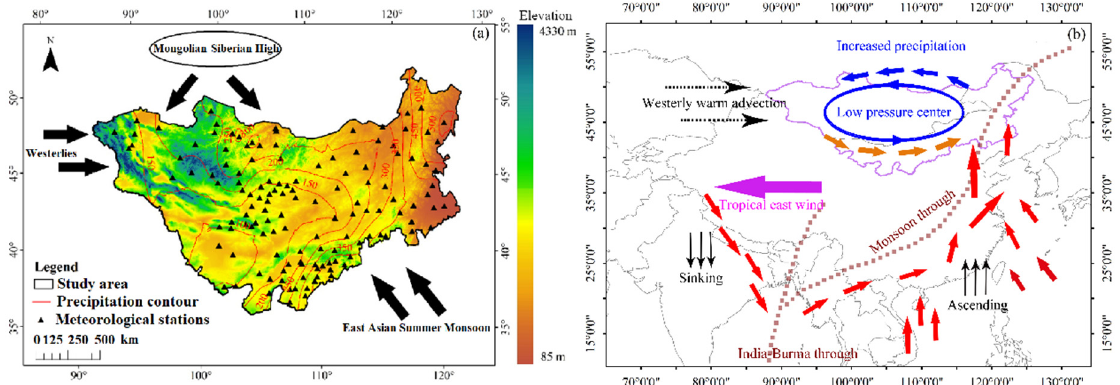
Figure 1. The Mongolian Plateau ( a ) the distribution of meteorological stations and annual average precipitation and ( b ) atmospheric circulation system [57].